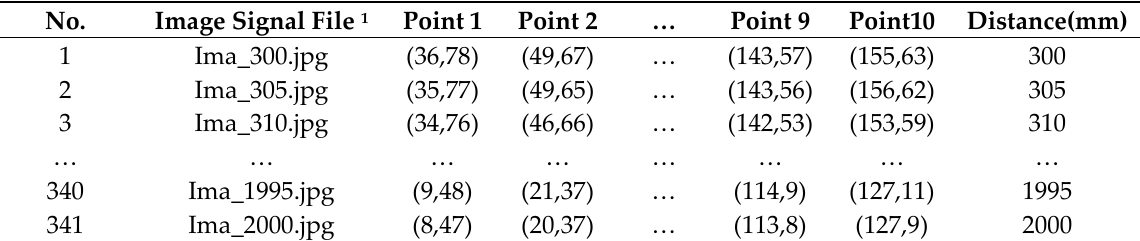
Table 1. Data set of